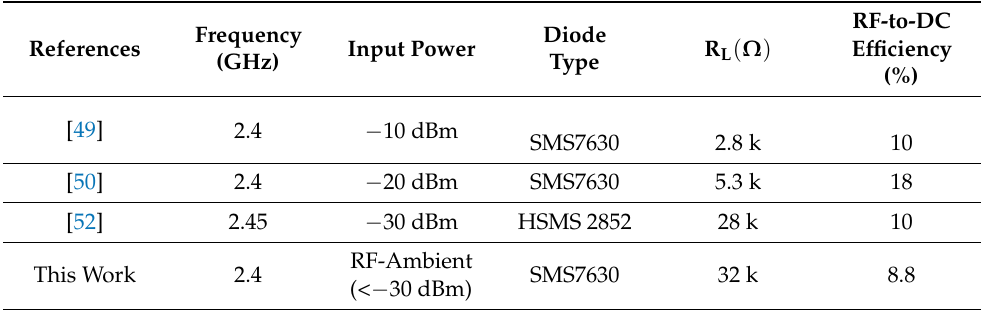
Table 1. Summarizes some of the more recent efficiencies reported in the literature with similar systems to the proposed in this